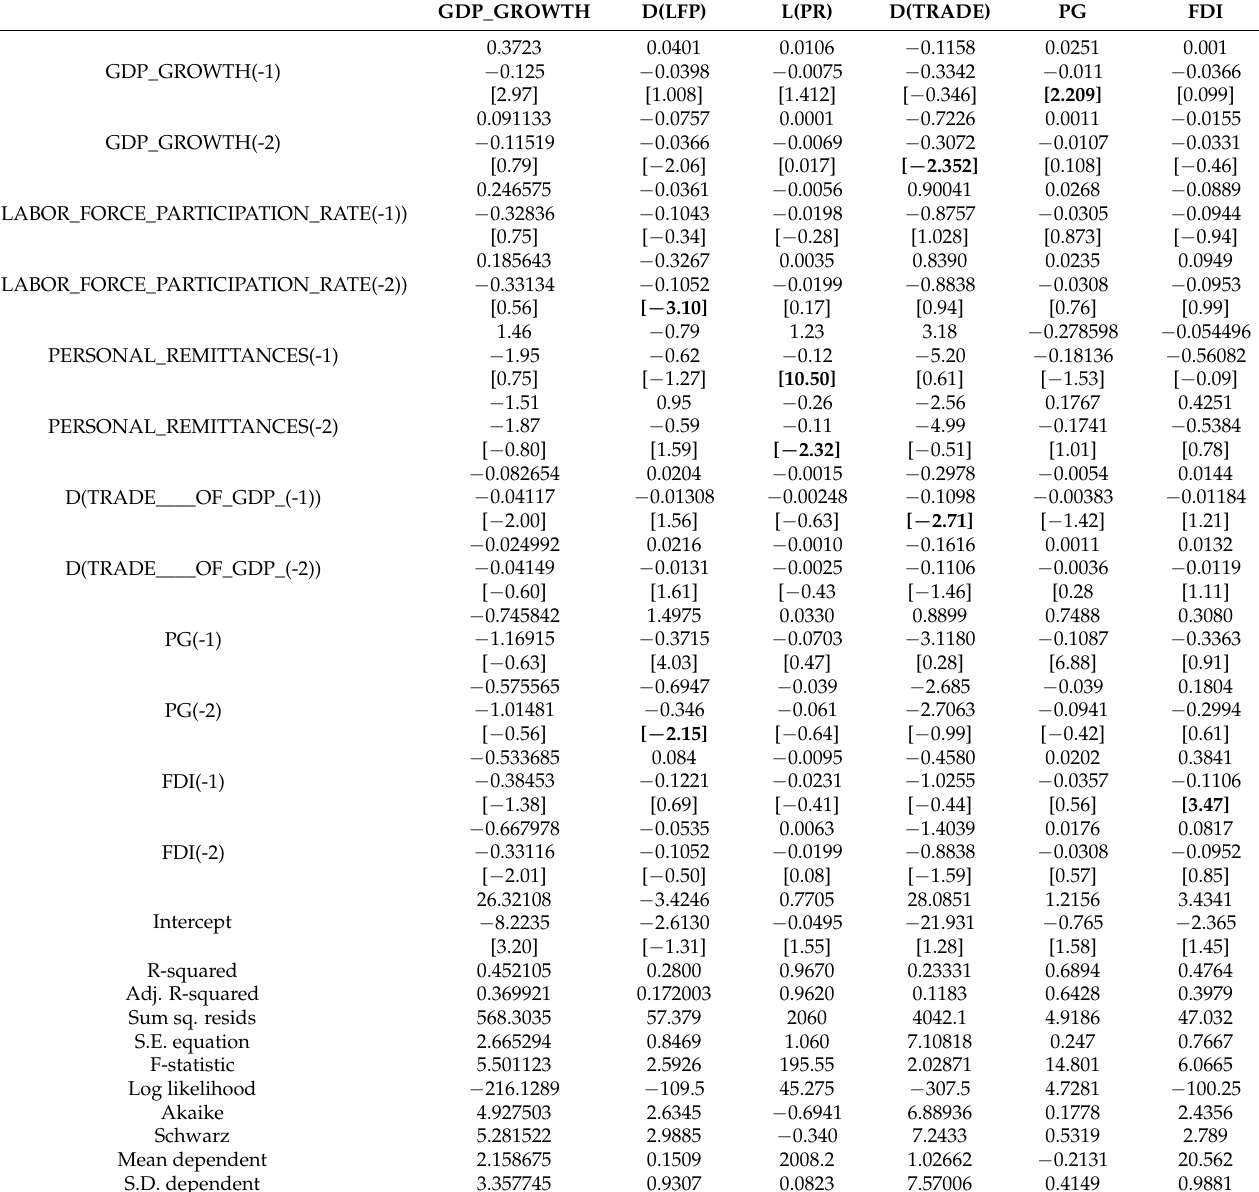
Table 5. Estimation output for gross domestic product (GDP) Growth—Vector Auto